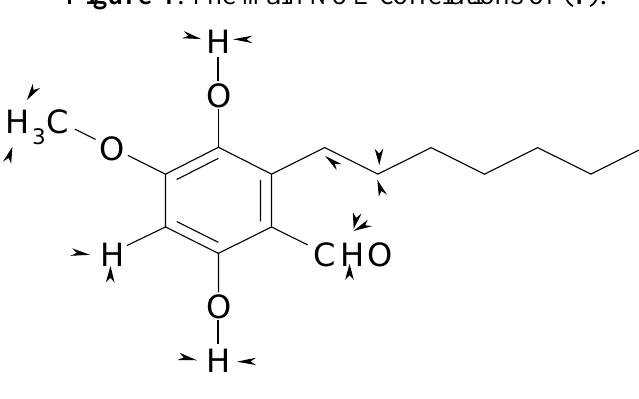
Figure 4 . The main NOE correlations of ( 1